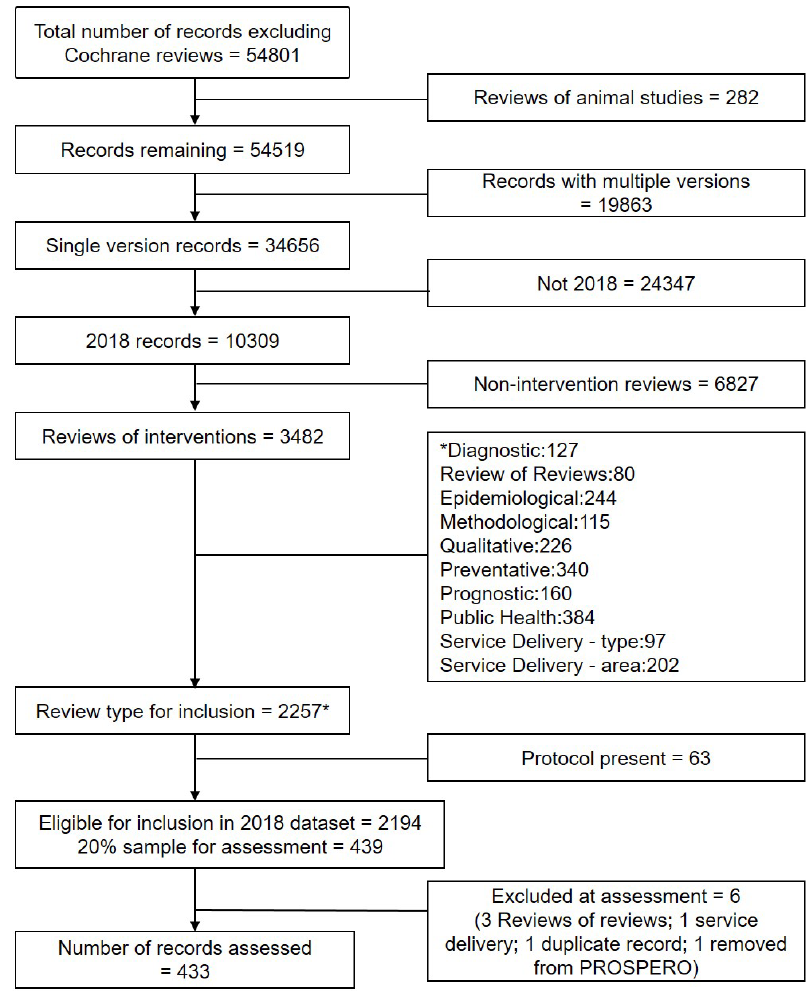
Figure 1. Flow chart of record sample